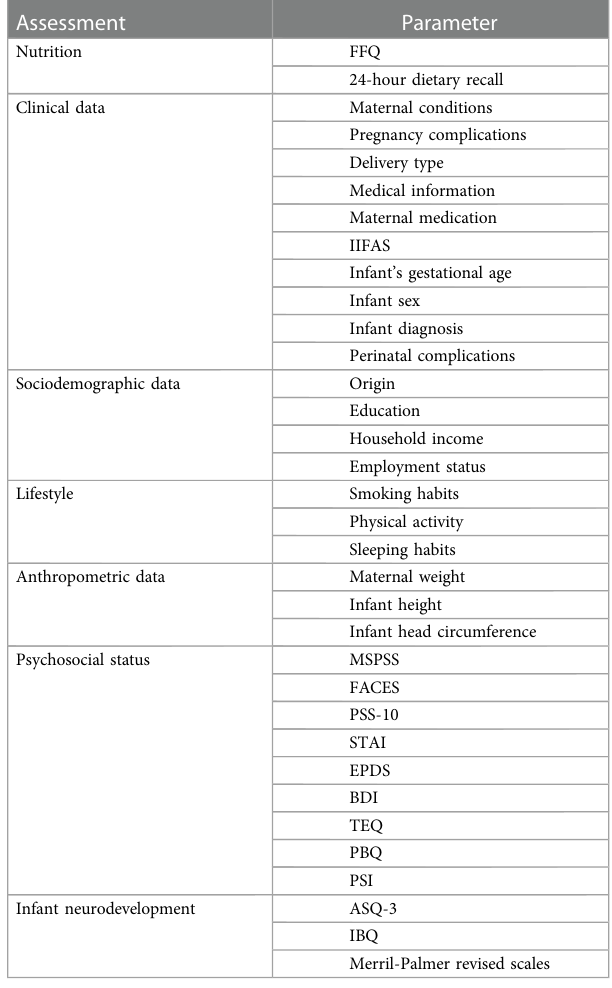
FFQ, FoodFrequencyQuestionnaire; IIFAS, Iowa InfantFeedingAttitude Scale; BMI, Body Mass Index; MSPSS, Multidimensional Scale of Perceived Social Support; FACES, Family Adaptability and Cohesion Evaluation Scale; PSS-10, Perceived Stress Scale-10; STAI, State-Trait Anxiety Inventory; EPDS, Edinburgh Postnatal Depression Scale; BDI, Beck Depression Inventory; TEQ, Traumatic Experience Questionnaire; PBQ, Postpartum Bonding Questionnaire; PSI, Parenting Stress Index; ASQ-3, Ages & Stages Questionnaires; IBQ, Infant Rothbart ’ s Temperament